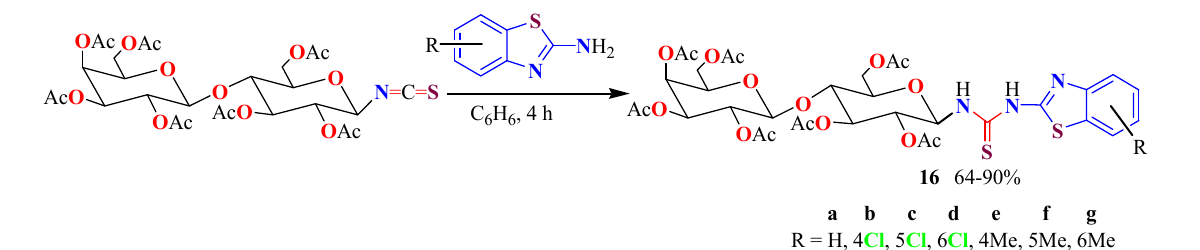
Scheme 7. Synthesis of substituted hepta-O-Acetyl- β -D-lactosyl-TBTs. A series of 45 different 6-substituted-aryl-UBTs 17 , 19 , and 20 and 6-substituted-aryl- TBTs 18 were synthesized from the reaction of the corresponding 6-substituted-2ABT with CDI or TCDI in stirring CH 3 CN at room temperature, then reacted with amines in DMF on heating 100 °C, Figure 3 [125]. Using an ELISA-based screening assay, the Frentizole SAR was identified as a novel UBT inhibitor of the interaction of amyloid beta peptide (A β ) and A β -binding alcohol dehydrogenase (ABAD) [A β -ABAD], recently implicated in the pathogenesis of Alzheimer’s disease (AD), with a 30-fold improvement in potency. In summary, all synthetized compounds were identified as micro molar inhibitors of the A β - ABAD interaction. The compounds 19h and 19l showed the most potent inhibition with IC 50 values of 6.46 and 6.56 μ M, respectively.